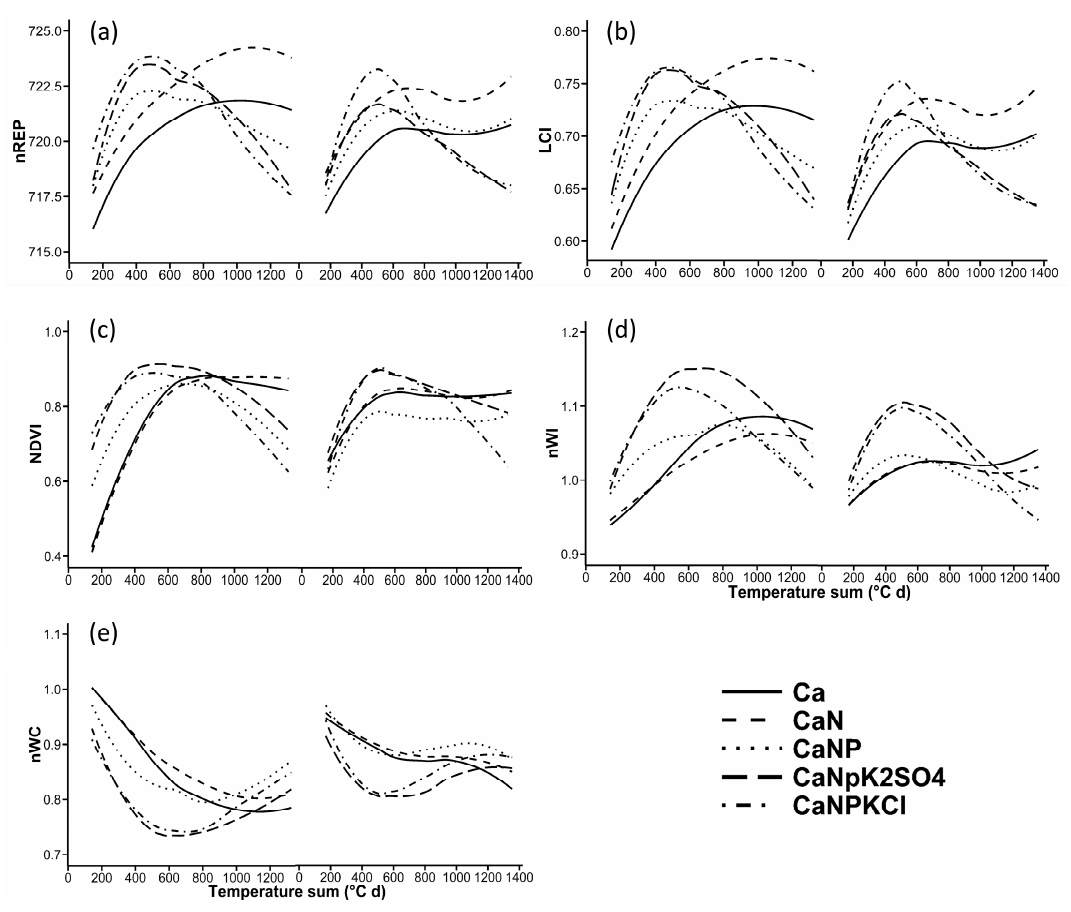
Figure 2. Smoothed curves of temporal development of ( a ) nREP, ( b ) LCI, ( c ) NDVI, ( d ) nWI and ( e ) nWC in Growing Seasons 1 and 2.